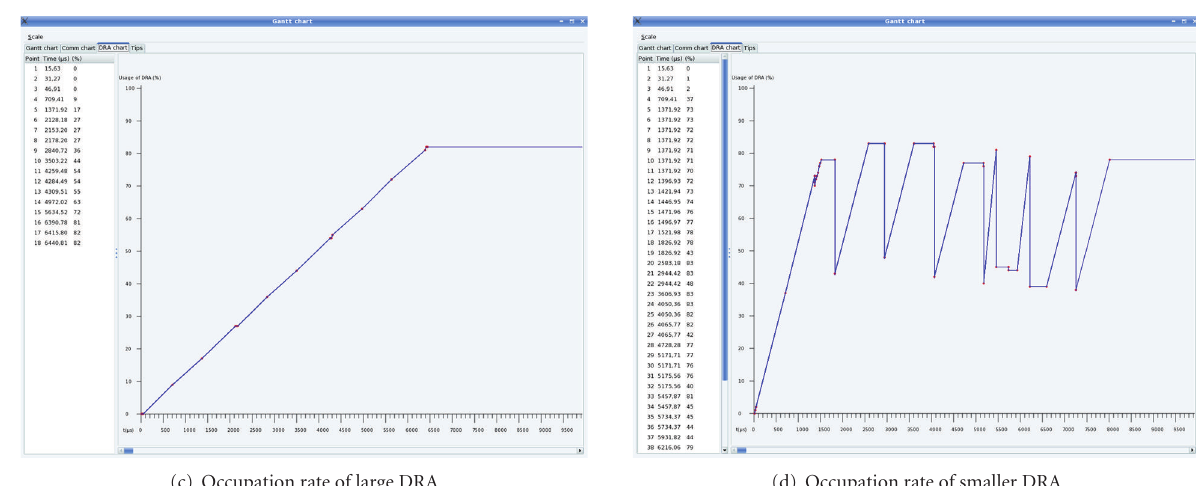
Figure 16: (a) and (b) represent the Gantt diagram for all the application tasks in both software on 3 processors and in hardware on a DRA of 4500 slices on the left and 3000 on the right. (c) and (d) represent the evolution of the DRA occupation over the